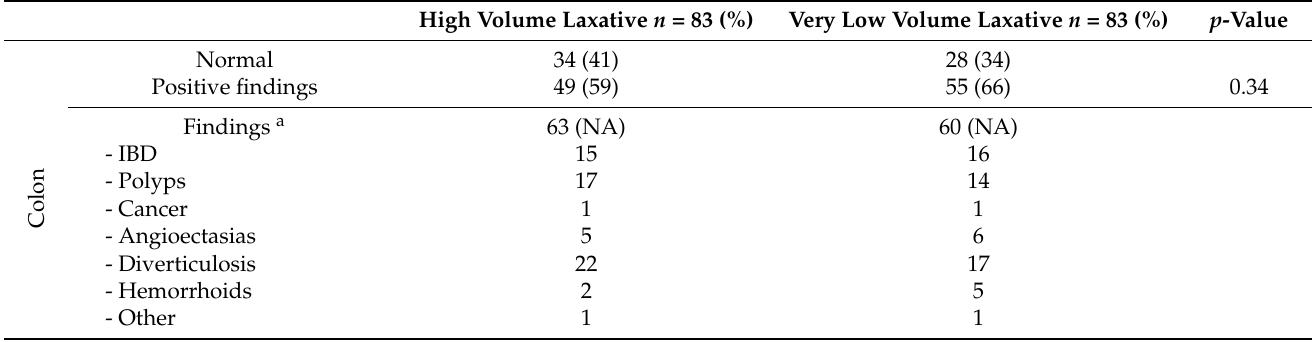
Table 4. Capsule endoscopy outcome.